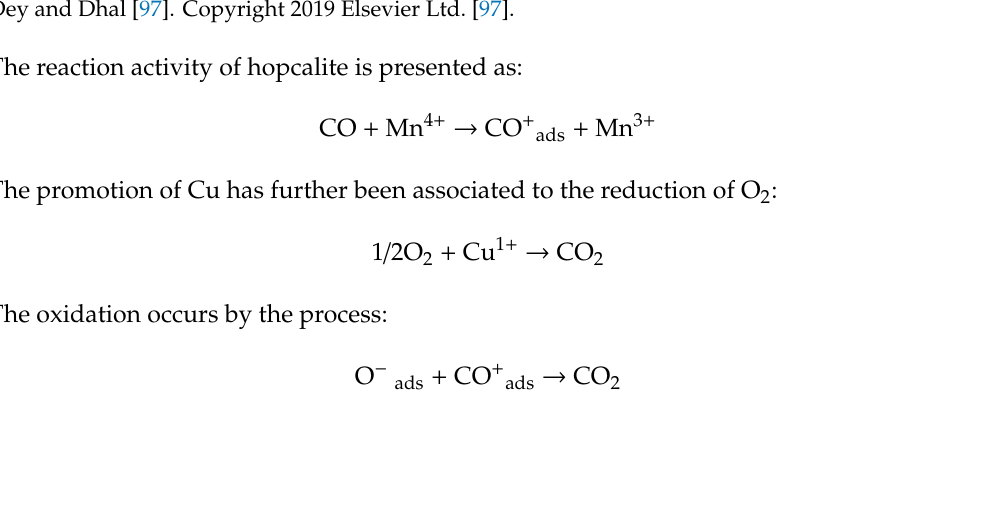
Figure 11. Regeneration of hopcalite catalysts after CO oxidation. Reproduced with permission from Dey and Dhal [97]. Copyright 2019 Elsevier Ltd.